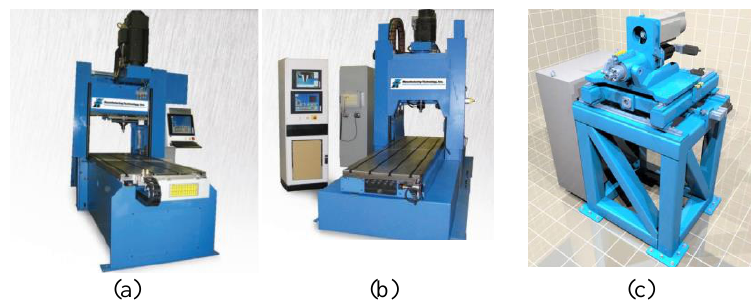
Fig. 2. Small-sized machines of firms MTI (USA) (a) and (b) and Novatech (USA) (c).